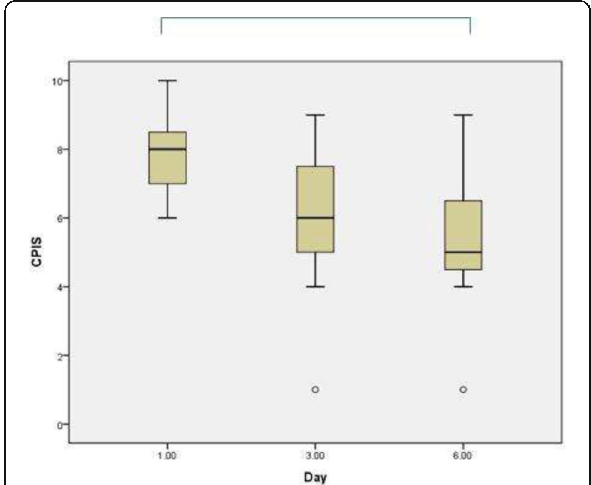
Fig. 1 (abstract 0018). CPIS change at D1, D3, and the end of treatment